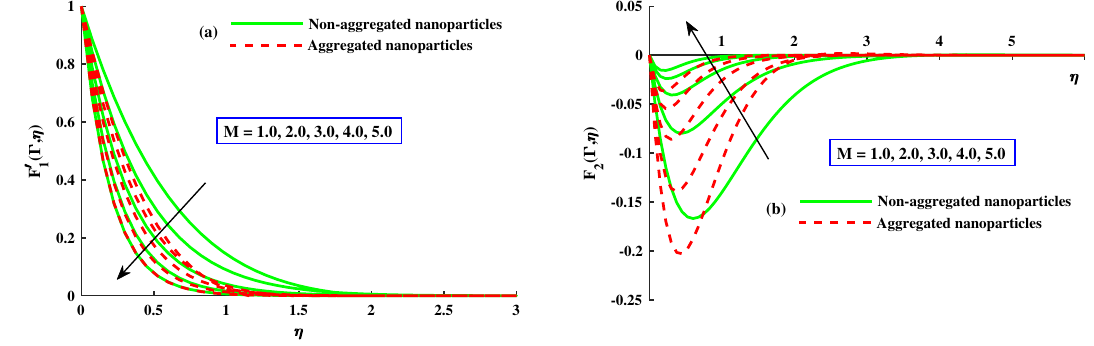
Figure 3. Variation of M on F ′ 1 (Ŵ , η) in axial, and F ′ 2 (Ŵ , η) in transverse.